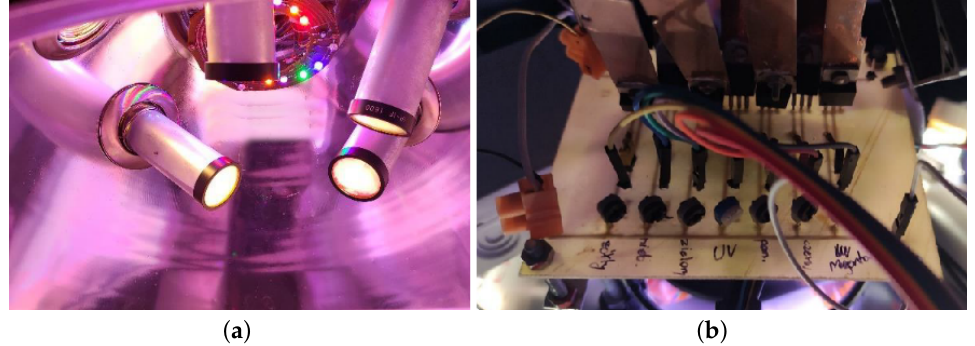
Figure 2. Solar simulator: ( a ) the system of heat emission sources, ( b ) thyristor. In order to match the spectral distribution of the simulator to the requirements de- scribed in standard [25], the diode set was equipped with a constructed thyristor current control system, shown in Figure 2b. The radiation distributions obtained in the simulator set against the solar radiation distribution are shown in Figure 3.